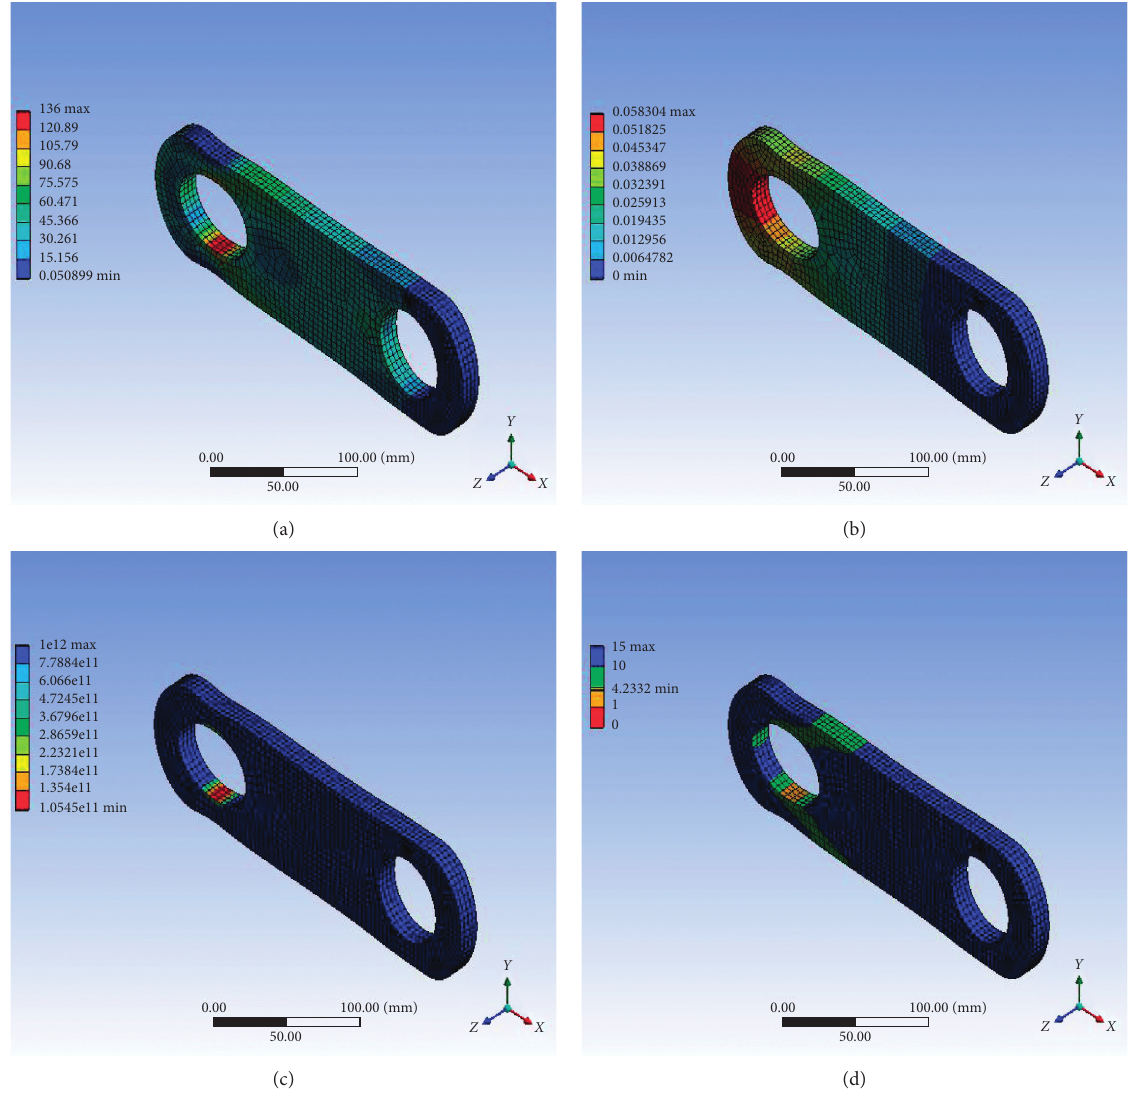
Figure 9: Simulation results for chain link without a modeled crack with neck radius 621.5 mm ( X � 2mm): (a) equivalent stress, (b) deformation, (c) fatigue life, and (d) safety